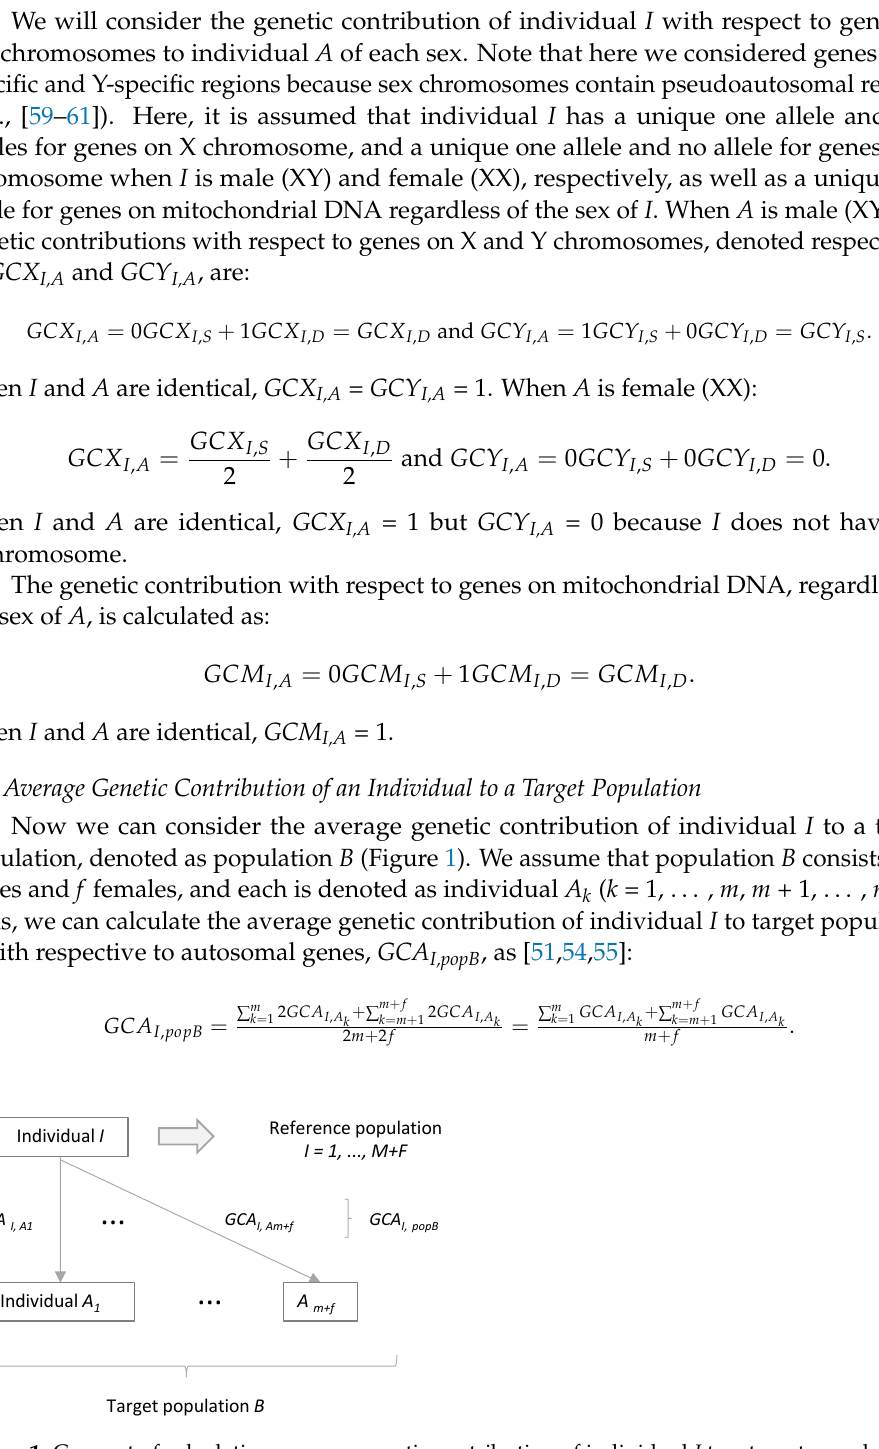
Figure 1. Concept of calculating average genetic contribution of individual I to a target population B , showing GCA as an